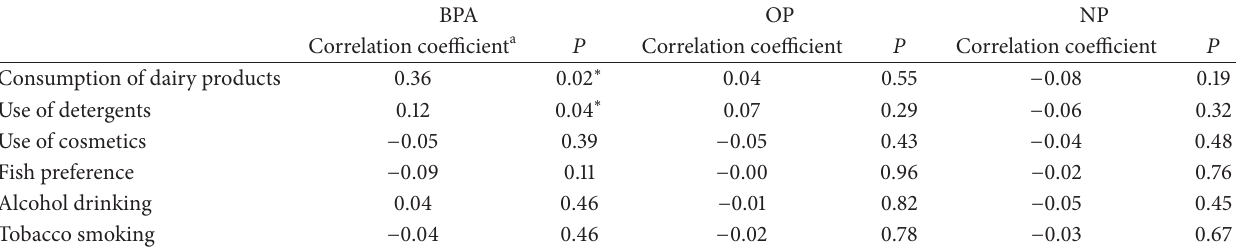
Table 3: Correlations between total phenol levels and candidates of exposure sources. BPA OP